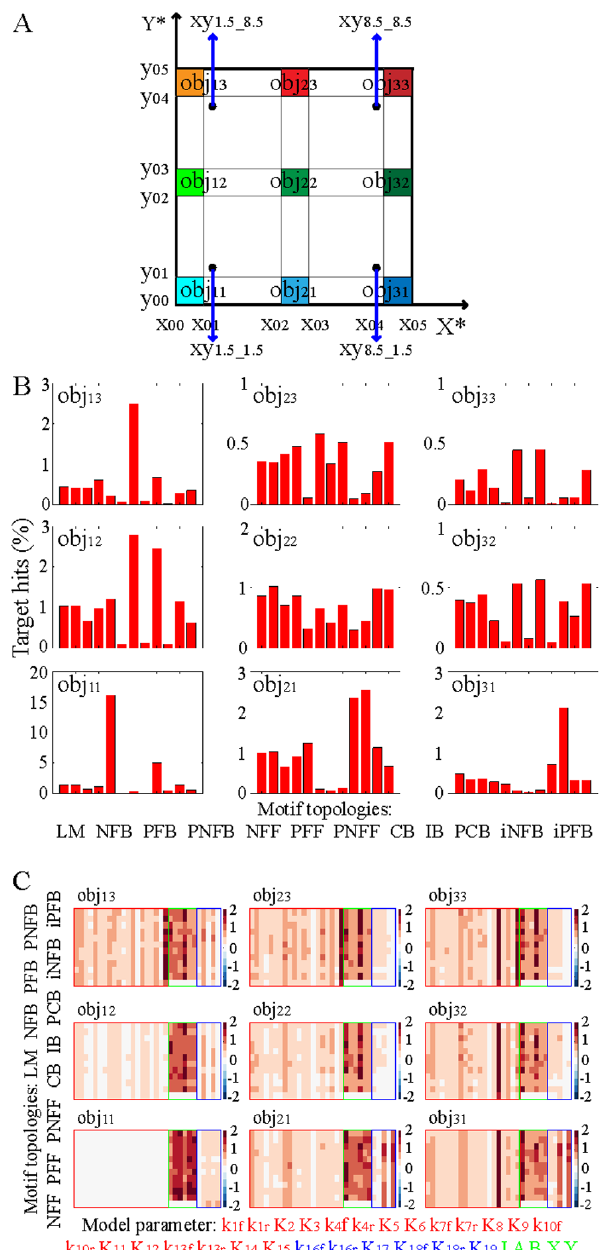
Figure 2. Functional tunability of network motifs to attain static output objectives. A: Predefined steady-state objective: [x